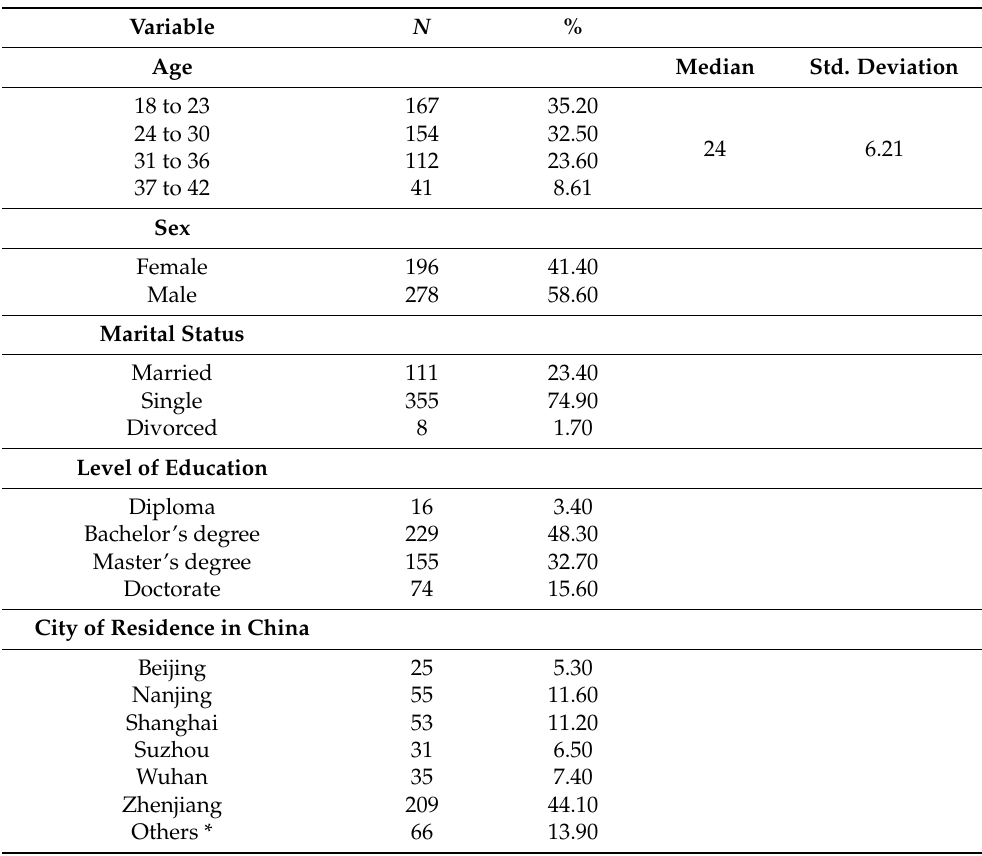
Table 2. Socio-demographic characteristics of